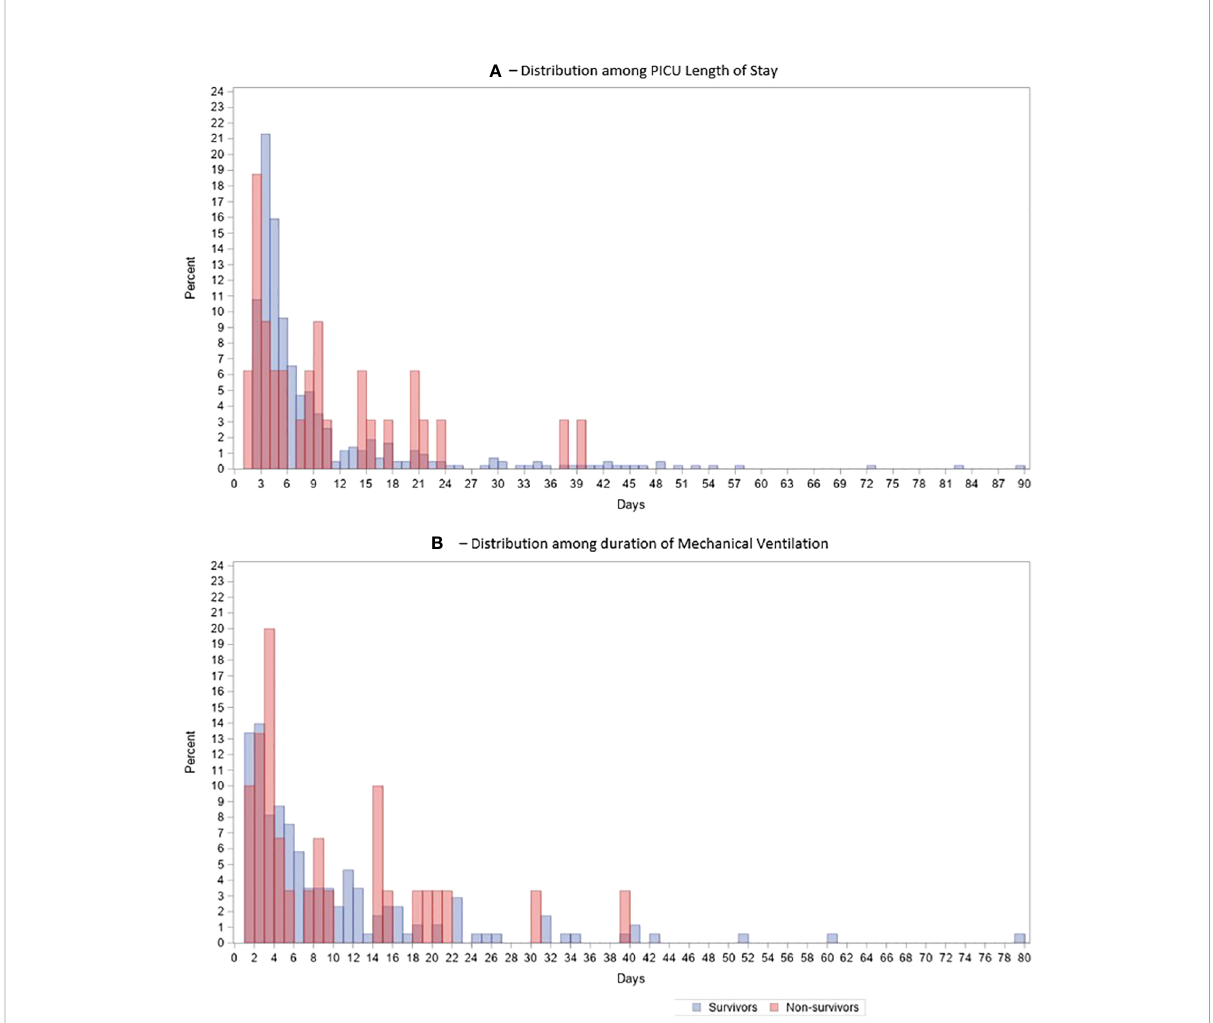
FIGURE 1 Histogram Distribution of Survivors vs Non-survivors over time, (A) Distribution over days of PICU stay, (B) Same distribution over duration of Mechanical